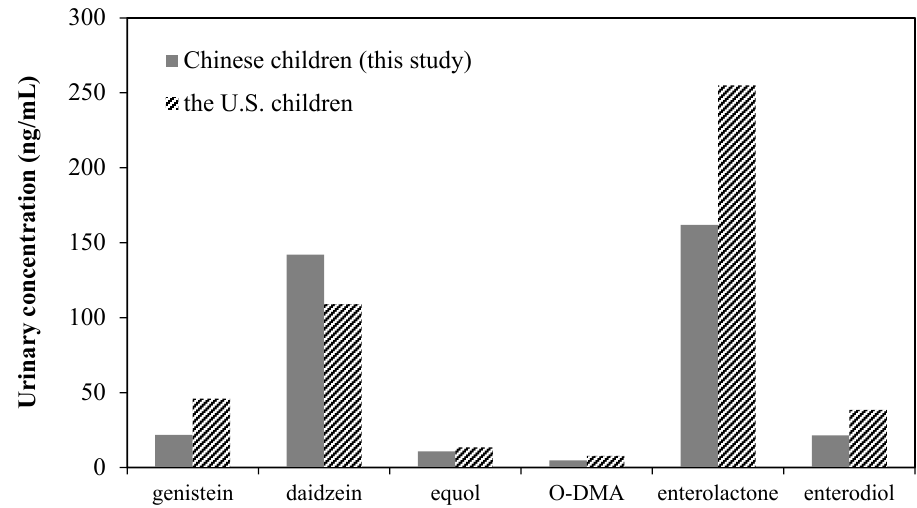
Figure 1. Chronological changes of GM concentration urinary BPA in children from China; Data comes from reference 11-13 and the results of current study.